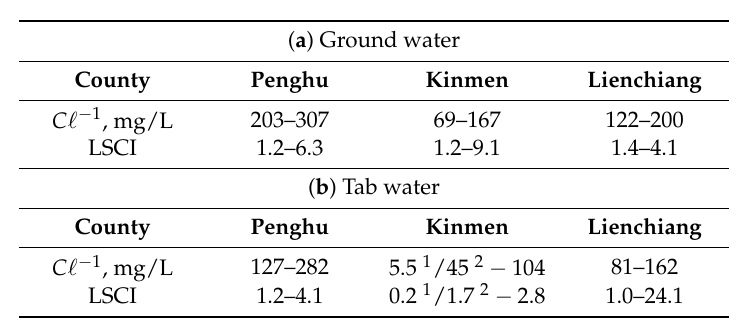
Table 9. Comparison of the Larson-Skold Corrosive Index (LSCI) and chloride ion concentration for ( a ) ground water and ( b ) tap water among three remote-island